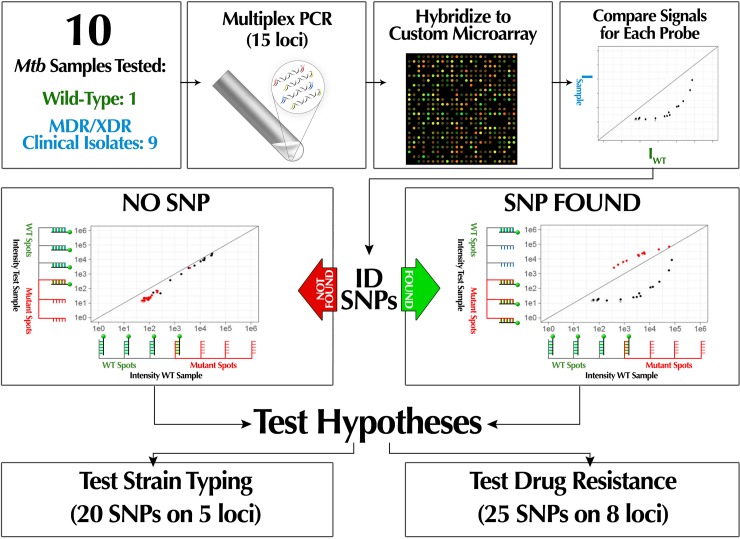
Scheme depicting experimental workflow and data interpretation.A 15-loci multiplex PCR developed in this study serves to generate sufficient analyte DNA from the targeted genes relevant to drug resistance and strain typing. Conceptual diagrams overlayed onto example dot plots of microarray data illustrate how hybridization signals from each probe set can distinguish between two alleles differing by a single polymorphism. Comparison with results from wild-type control samples and alternative mutant alleles allows determination of the specific nucleotide at the tested position.